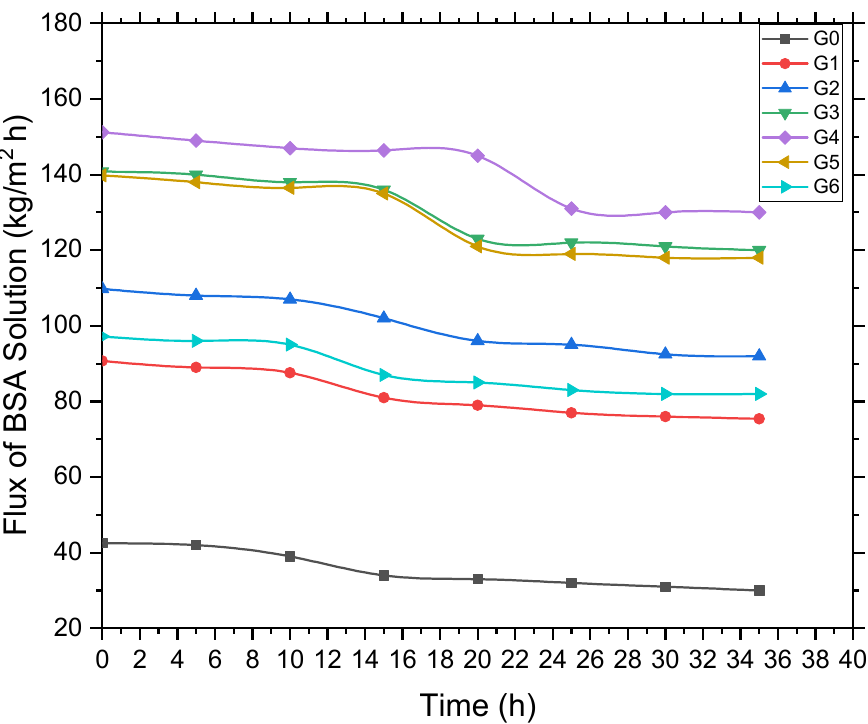
Figure 11. Permeate fluxes of the membrane as a function of exposure time over 250 h of 1000 ppm BSA feed solution.